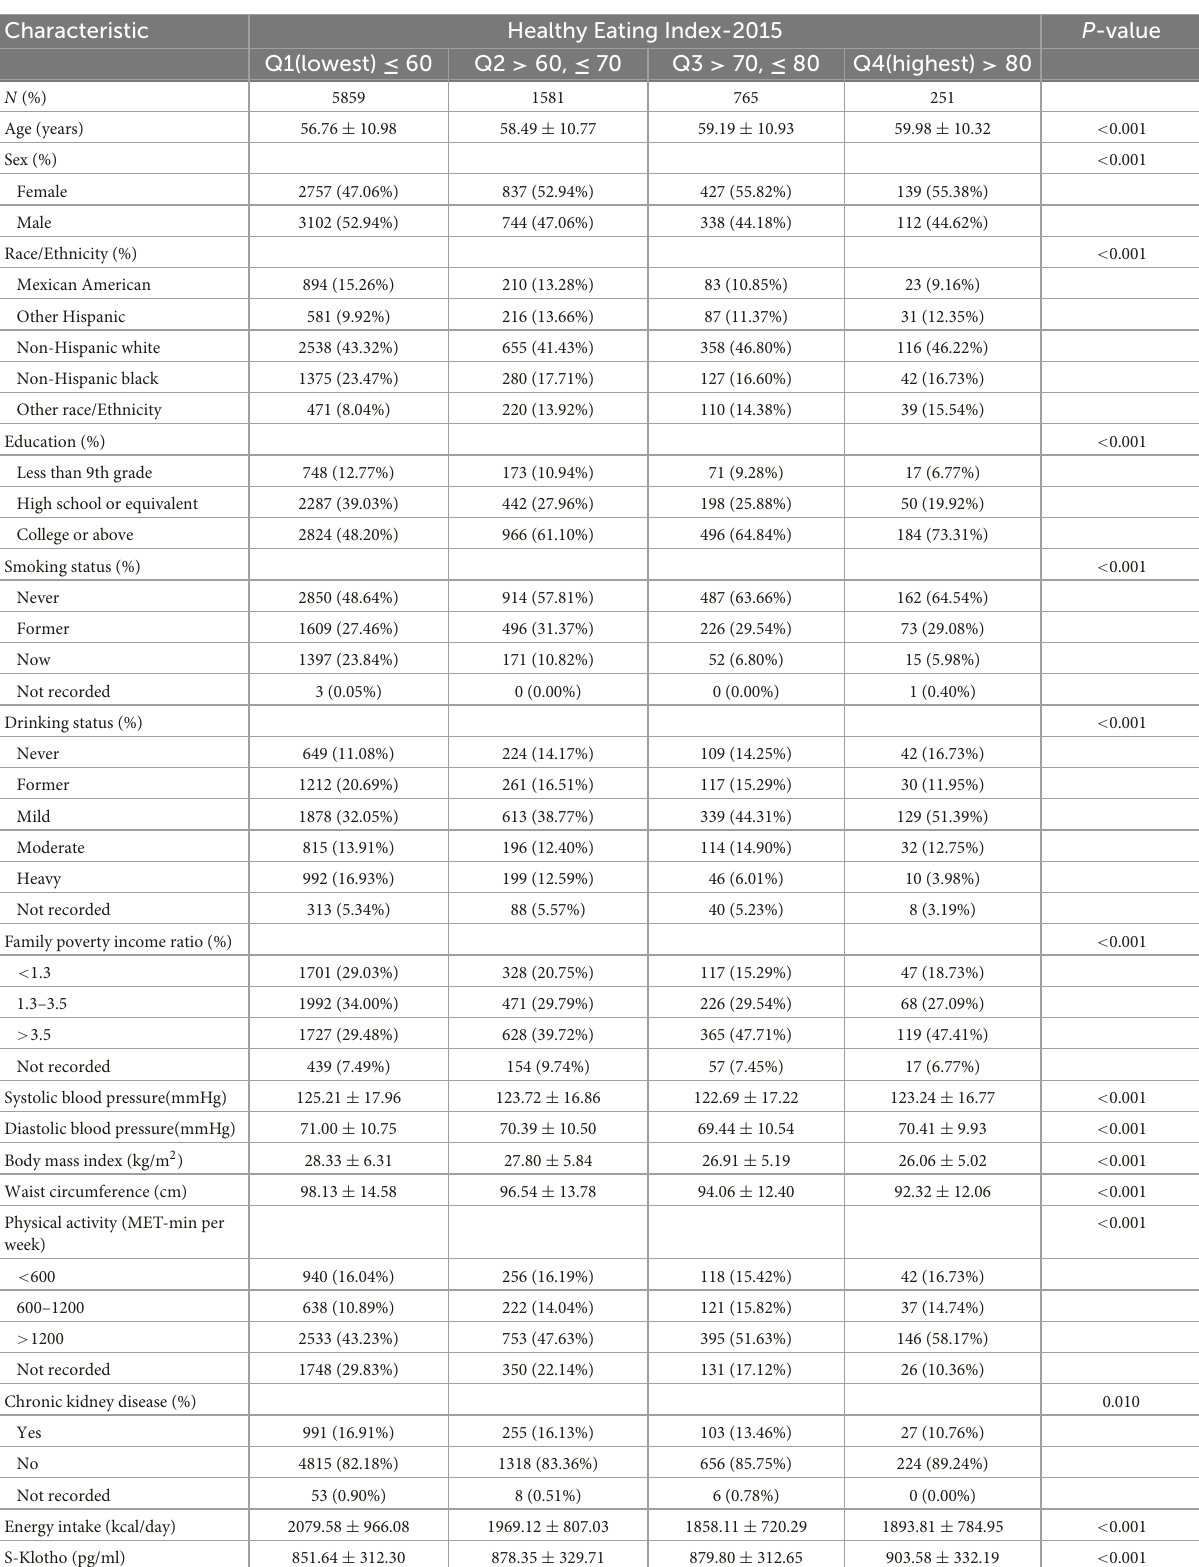
TABLE 1 Baseline characteristics of